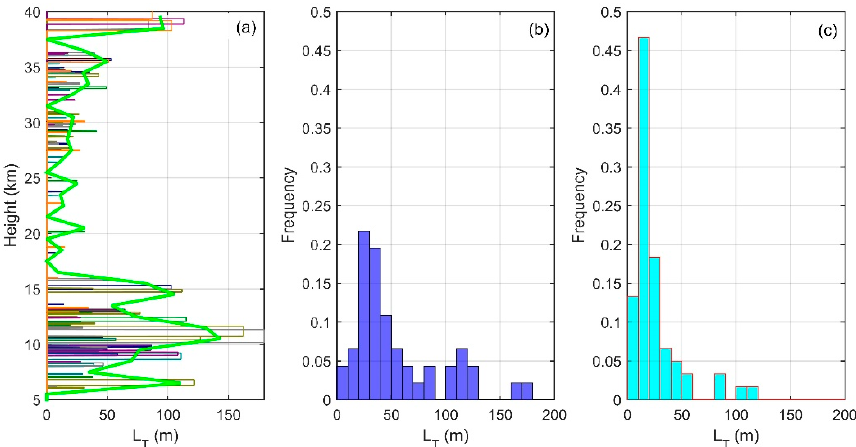
Figure 5. Vertical distribution of L T ( a ) and frequency distribution of L T in the troposphere ( b ) and in the stratosphere ( c ).